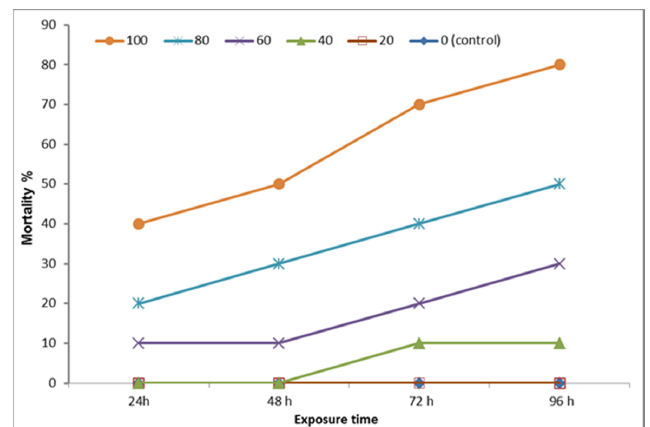
Figure 2. Mortality percentage of fish exposed to different concentration of NaF (20, 40, 60, 80, and 100 mg/L) at different time points (24, 48, 72, and 96 h). The total number of fish/group = 10 fish. Table 3. Determination of sodium fluoride LC50 in O. niloticus.